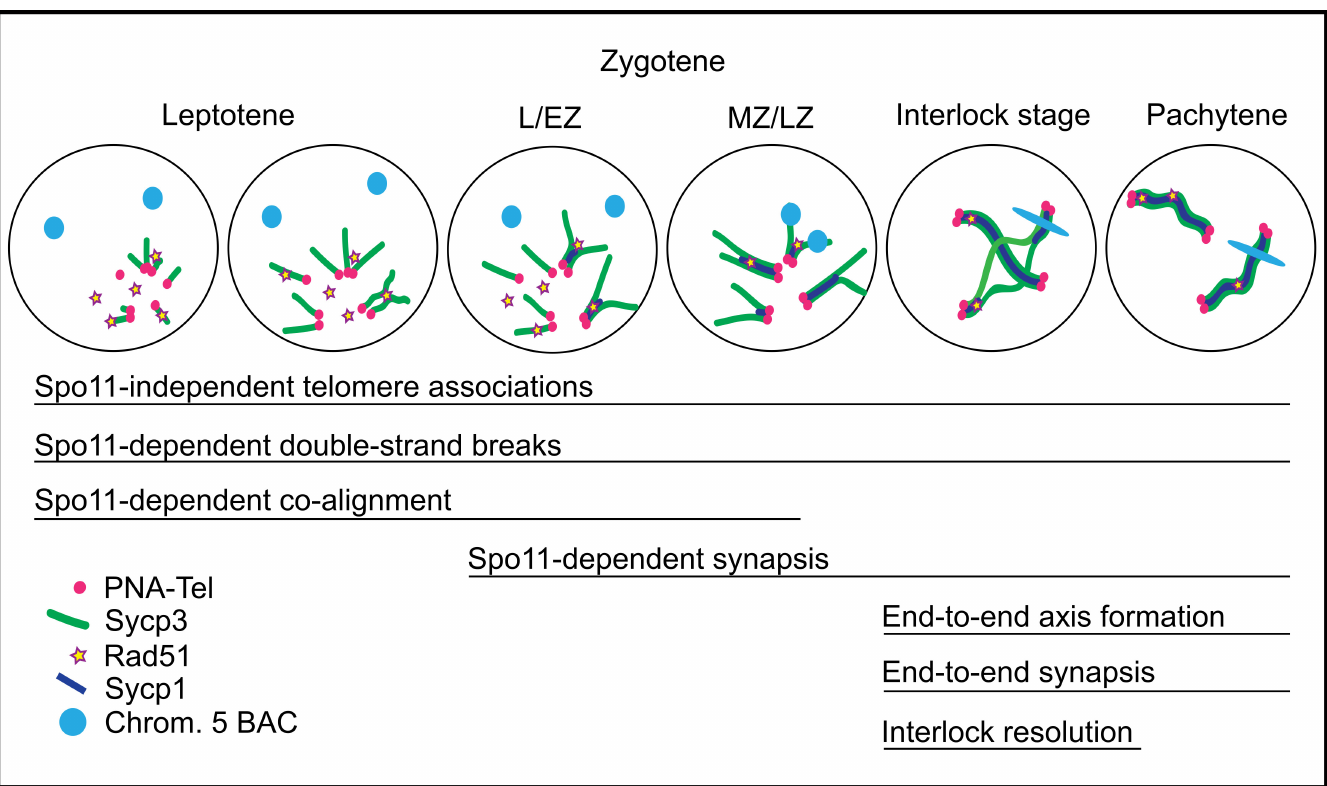
Fig 11. Model of the temporal progression of the chromosome events of meiotic prophase I. At leptotene, Sycp3 lines originate at the telomeres and elongate by extending toward the center of the chromosome. Initiation of Sycp3 growth is contemporaneous with the presence of Rad51 foci. Neither homolog alignment at interstitial regions nor synapsis are apparent, but some co-alignment of axes (less than 0.5 μ m) near telomeres occurs. Zygotene stages, L/EZ and MZ/LZ, are defined in Fig 2 as leptotene/early zygotene and mid to late zygotene, respectively. At these stages, synapsis initiates between Sycp3 axes, yet not all Sycp1 lines are associated with a Rad51 focus. Close, stable homolog juxtaposition occurs as synapsis elongates from the telomeres. At a pre-pachytene stage, interlocks and/or regional de-synapsis occurs. As homologs are paired, the BAC signal becomes elongated, suggesting it is contained in a chromosome